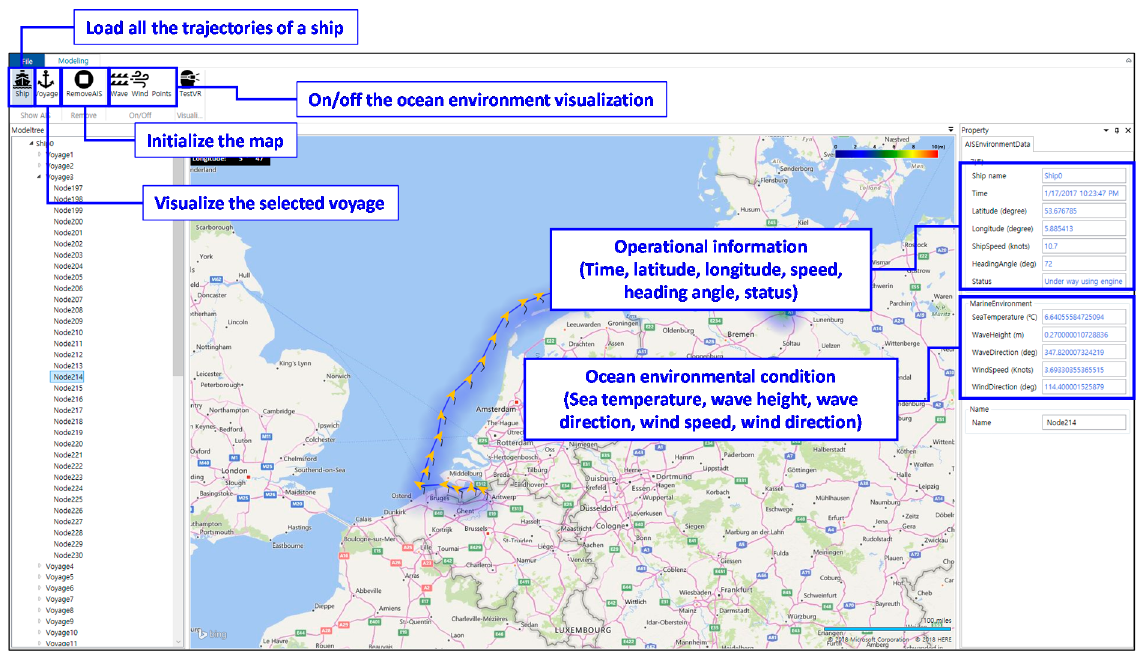
Figure 3. Functions and information of the AIS data and ocean environment data on the visualization program.